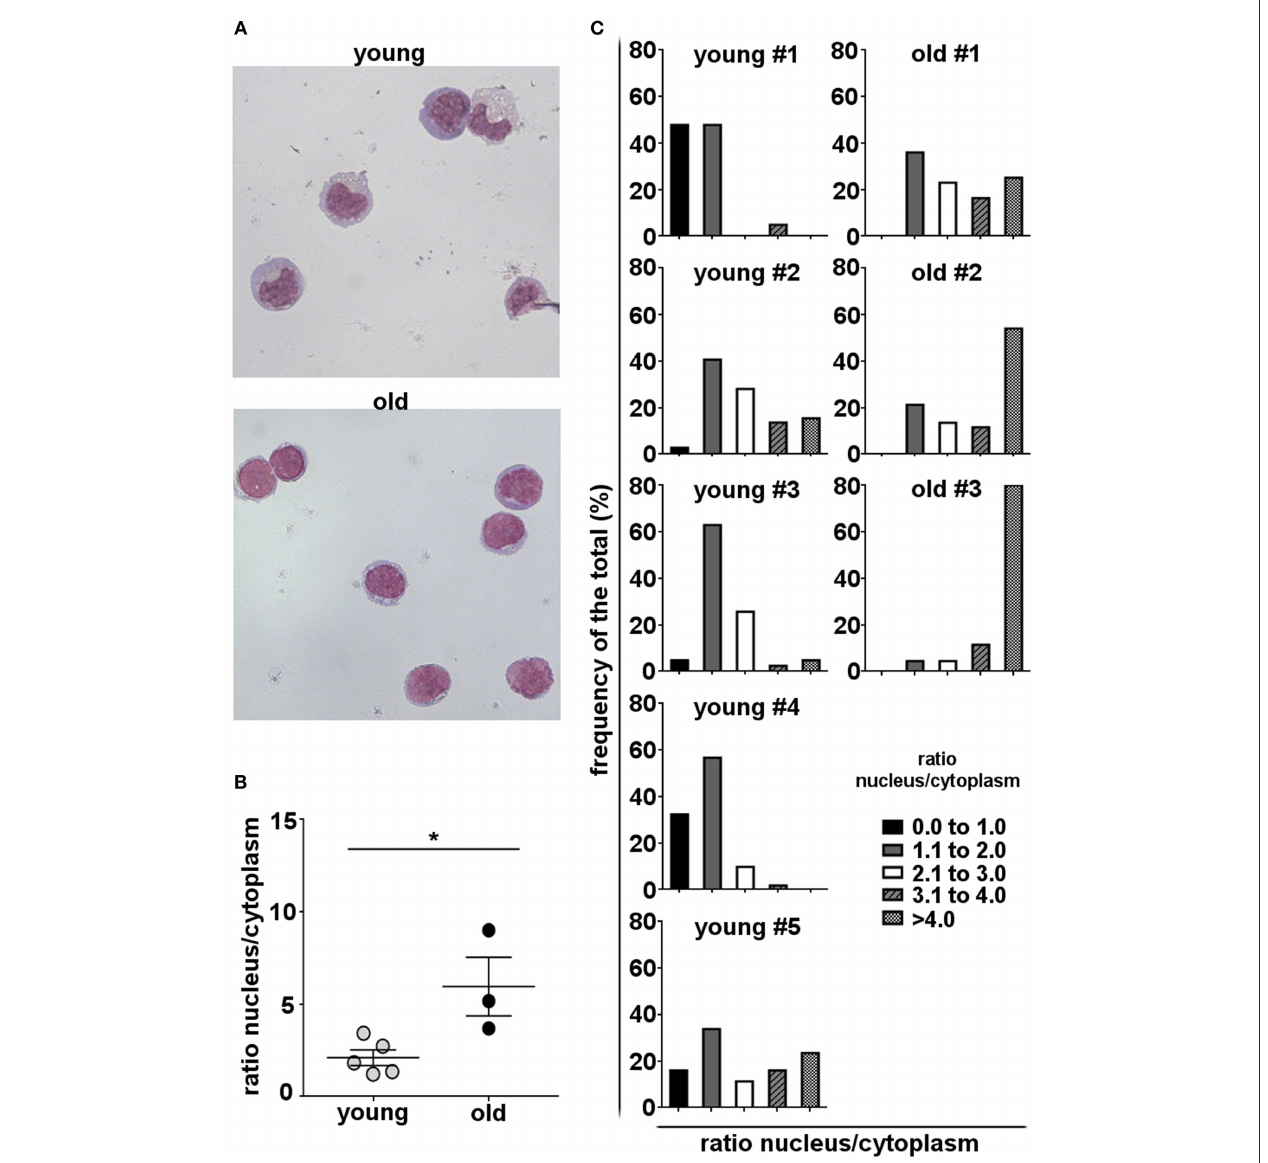
FIGURE 4 | Human B-1 cell morphology changes with advancing age. B-1 cells were sort-purified from PBMCs and stained with Wright–Giemsa stain. (A) Representative photomicrographs of B-1 cells from a young and an old donor are shown (magnification 60X). (B) Median nucleus/cytoplasm ratios of B-1 cells from young and old donors are shown. The diameters of the nucleus and the cytoplasm were measured by ImageJ software. Each dot represents the median of the nucleus/cytoplasm ratios calculated for each individual donor from the cells in 5–10 fields. * p < 0.05 by Mann–Whitney U -test, bars are means and standard errors of the means (SEM). (C) Frequency distributions of nucleus/cytoplasm ratios in B-1 cells from five young and 3 old donors are